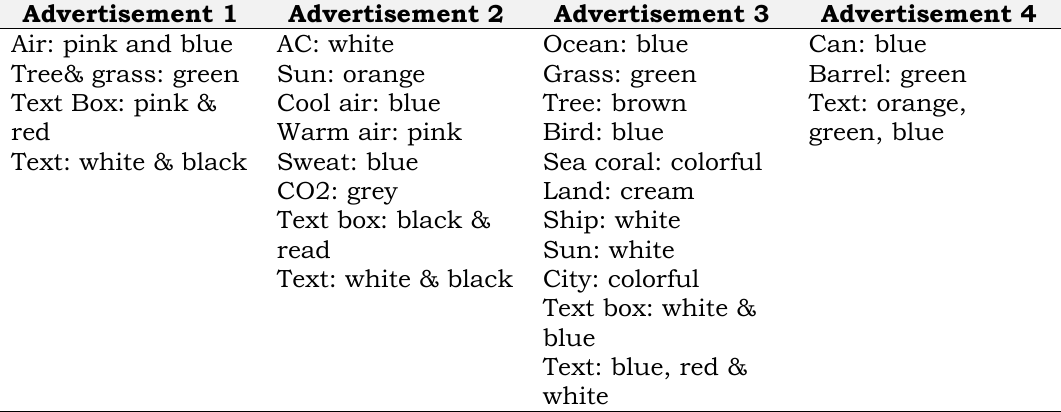
Table 2. The list of pictures used in the advertisements and the color of each item Advertisement 1 Advertisement 2 Advertisement 3 Advertisement